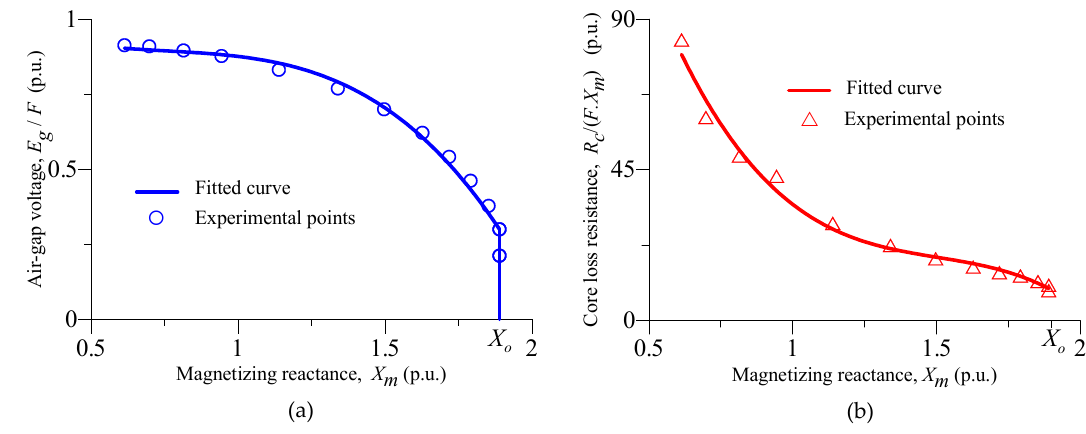
Figure 4. Variation of air-gap voltage and core loss versus magnetizing reactance X m : ( a ) Air-gap voltage E g / F ( b ) Core loss resistance R c /( F X m ).